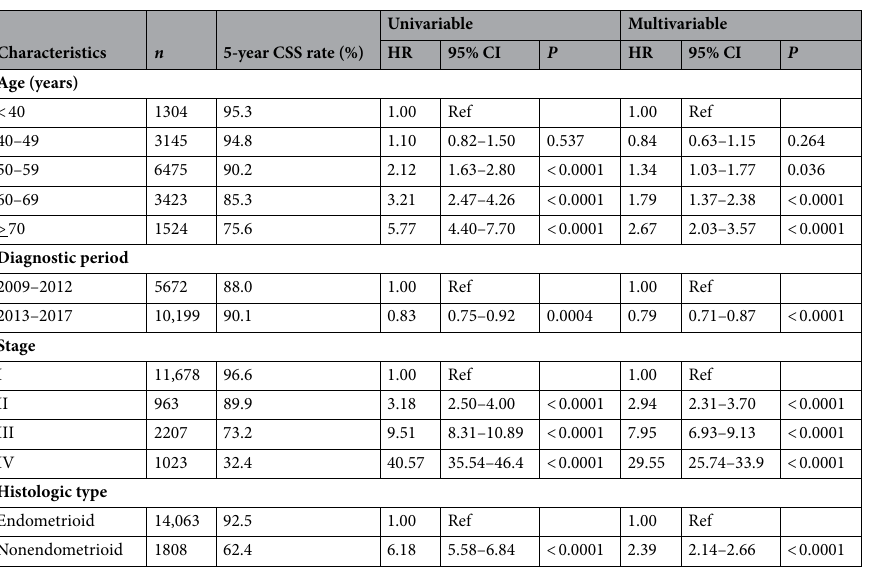
Table 2. Univariable and multivariable analysis of 5-year cancer-specific survival (CSS) rates for endometrial cancer patients in Taiwan, 2009–2017. HR hazard ratio, CI confidence